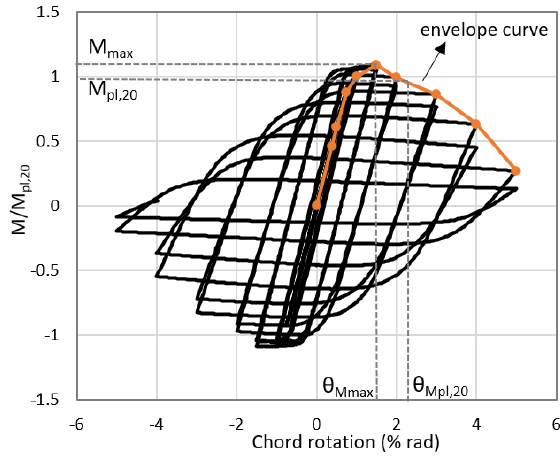
Figure 10. The first cycle envelope